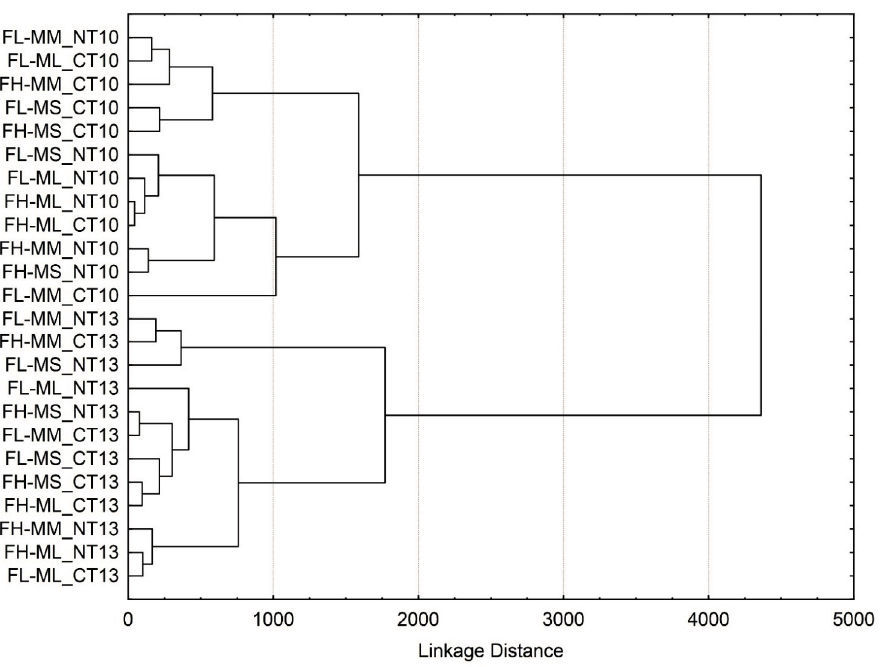
Figure 7. Dendogram comparing the influence of different agricultural practices on overall soil microbial activities during the 2009/2010 and 2012/2013 planting